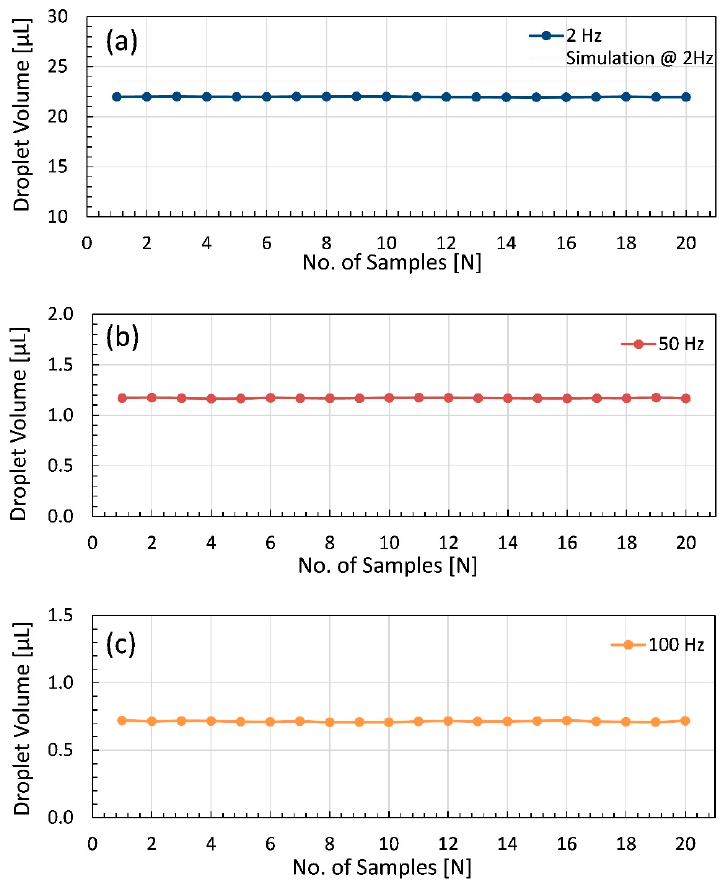
Figure 10. Volume of dispensed droplets of glycerin at various frequencies: ( a ) droplet volume at 2 Hz frequency and 250 ms open time with respect to simulation result at 2 Hz frequency and 260 ms open time; ( b ) droplet volume at 50 Hz frequency and 10 ms open time; ( c ) droplet volume at 100 Hz frequency and 5 ms open time.